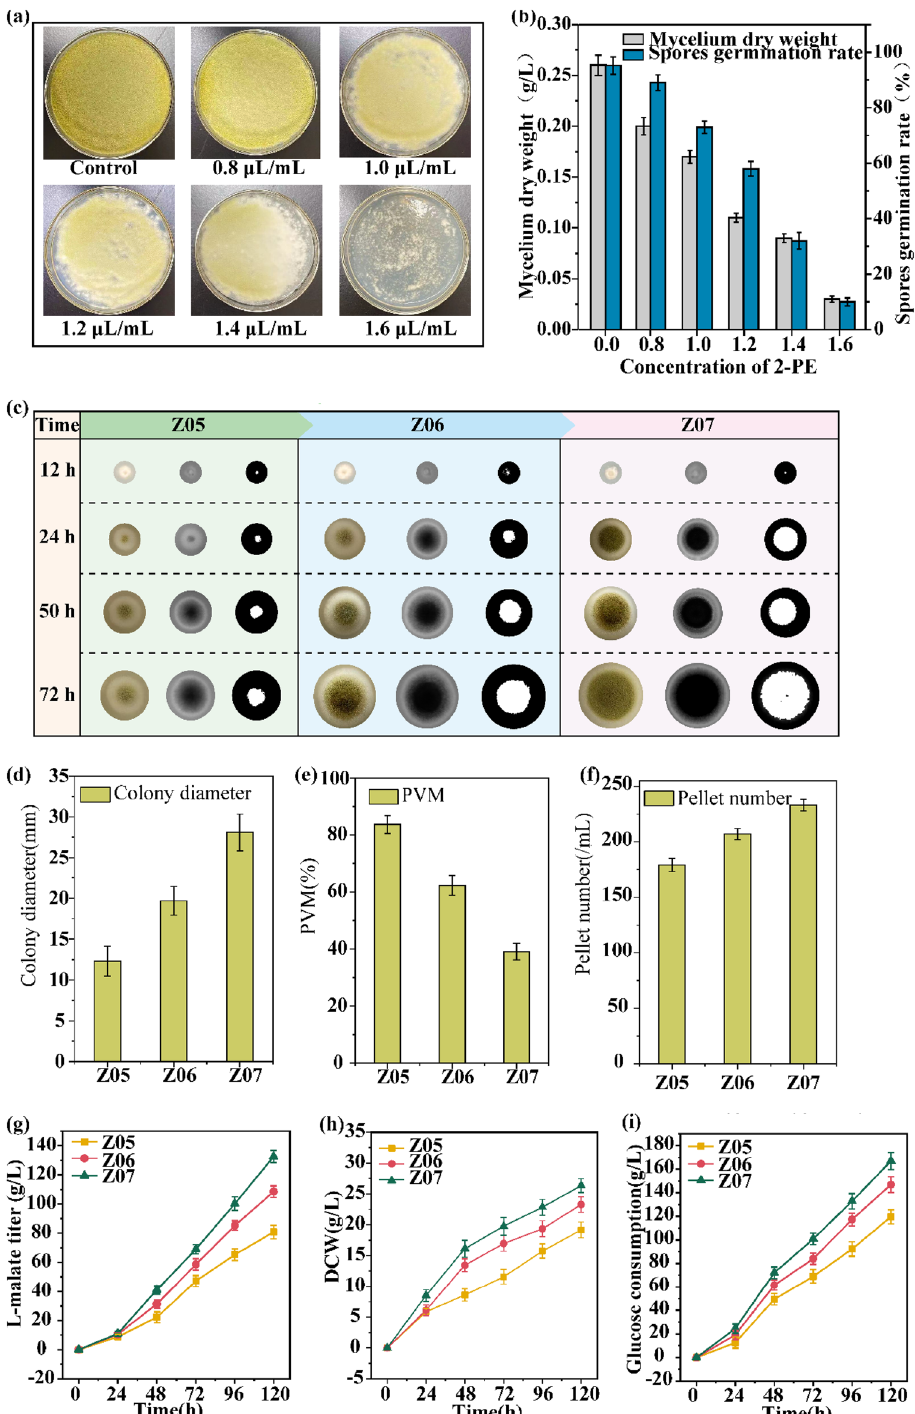
Fig. 2 Assessment of the adaptive evolution of Aspergillus oryzae strains. a Inhibition of Aspergillus oryzae by different concentrations of 2-PE. b Influence of different concentrations of 2-PE on changes in mycelial dry weight and spores germination rate. c Images of colony morphology, compactness and PVM values during the evolution of strain Z05, Z06 and Z07. d‑f Growth parameters: colony diameter, PVM value and pellet number of strain Z05, Z06 and Z07. g‑i Fermentation performance parameters: L-malate titer, DCW and glucose consumption of strain Z05, Z06 and Z07 in the 7.5-L fermenter. All data are presented as mean values from three independent experiments. Error bars indicate the standard